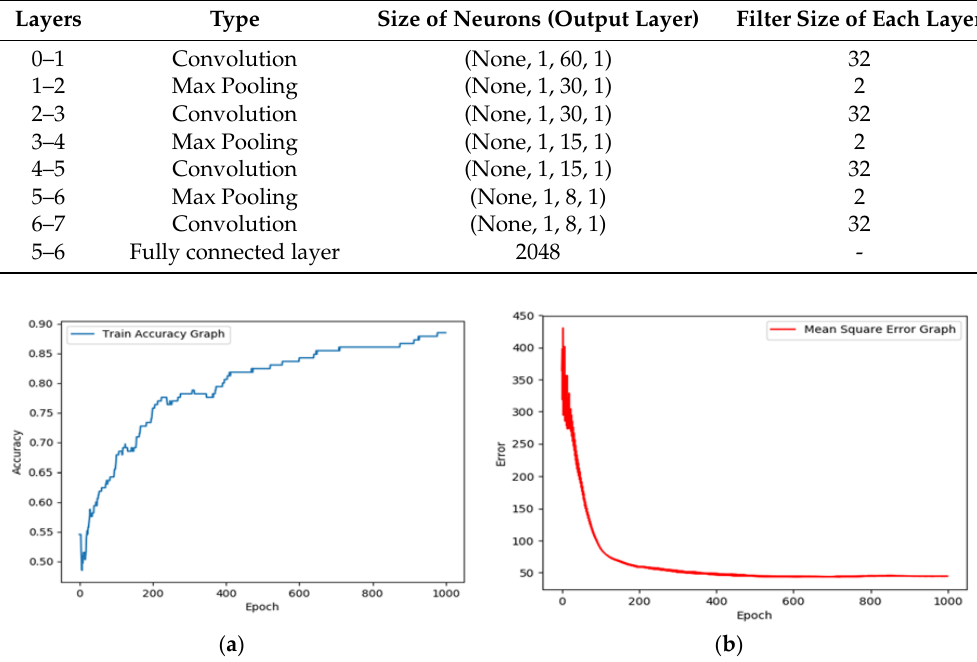
Figure 6. Accuracy and mean square error (MSE) graph of the MLP algorithm; ( a ) the accuracy of MLP increases as the number of epochs increases; ( b ) MSE reduces with every epoch and reaches the minimum point after 1000 epochs.